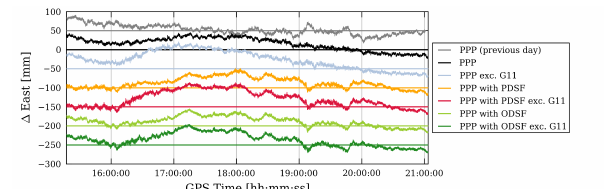
Figure 6: Easting errors between 15:17 and 21:04 (GPS system time) on August 31 2013 for receiver UCL resulting from standard PPP processing both with (black) and without (blue-grey) measure- ments from the satellite G11 on day 2. Similarly shown in other colors are the errors resulting from PPP processing with position- or observation-domain sidereal filters applied. Each of the time series have been offset from each other by appropriate multiples of 50 mm for